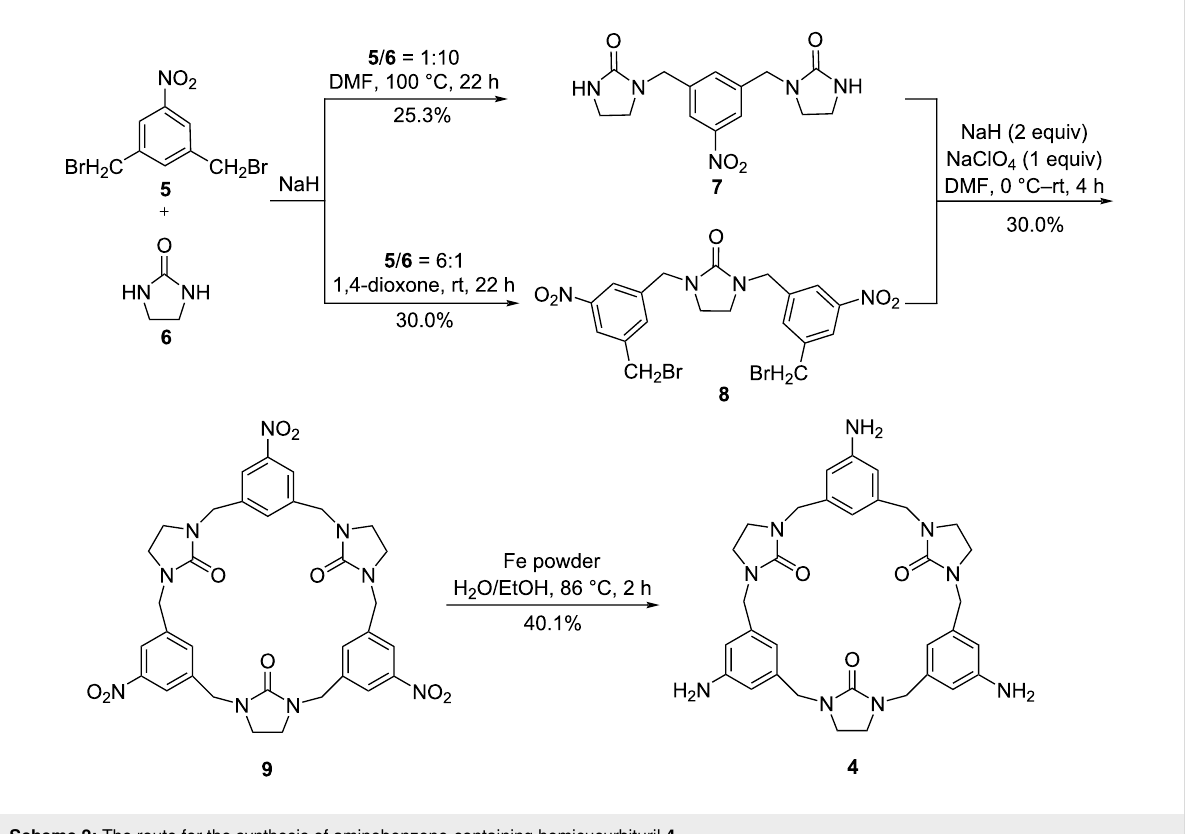
Scheme 2: The route for the synthesis of aminobenzene-containing hemicucurbituril 4